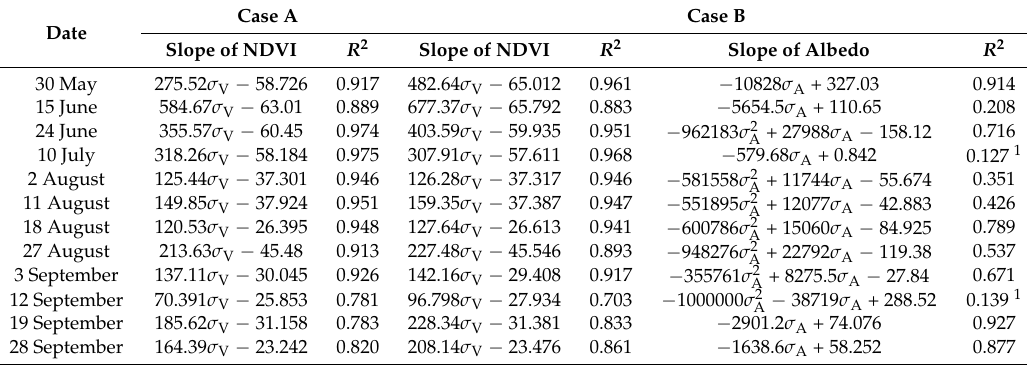
Table 1. The functions for predicting the slopes of descriptors in the regression functions for downscaling the ASTER LSTs with GRM on the 12